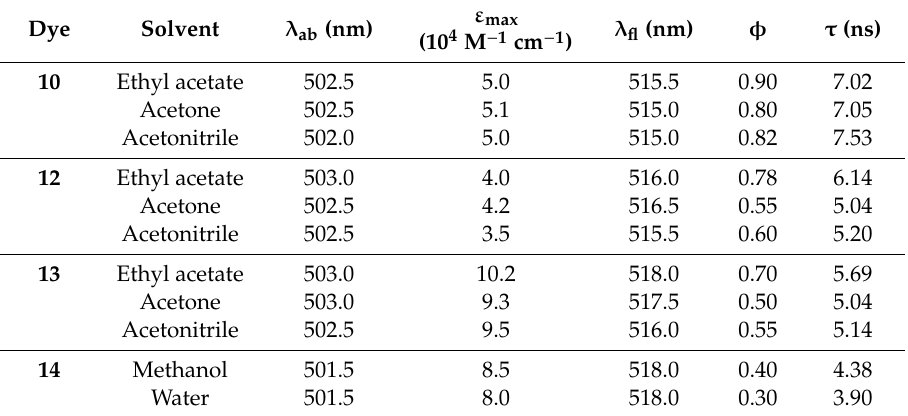
Table 1. Photophysical properties of diluted solutions (2 µ M) of boron-dipyrromethene (BODIPY)- labeled tetravalent ( 10 and 12) and hexavalent ( 13 and 14 ) derivatives in di ff erent solvents.